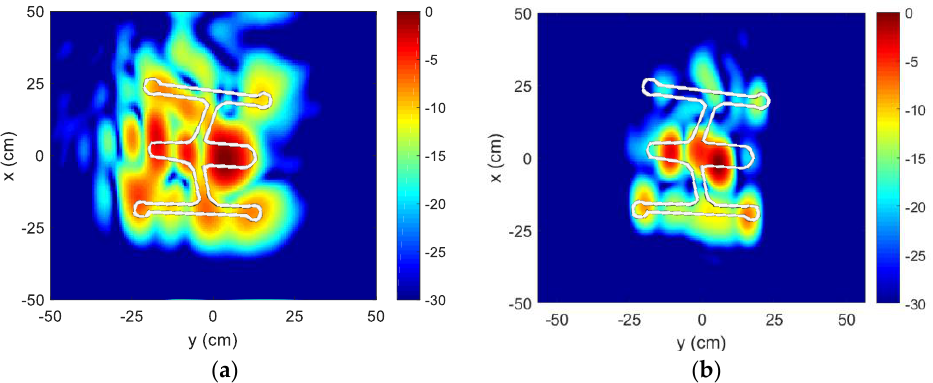
Figure 12. Reduced-aperture ISAR image. ( a ) In-flight; ( b ) Laboratory.